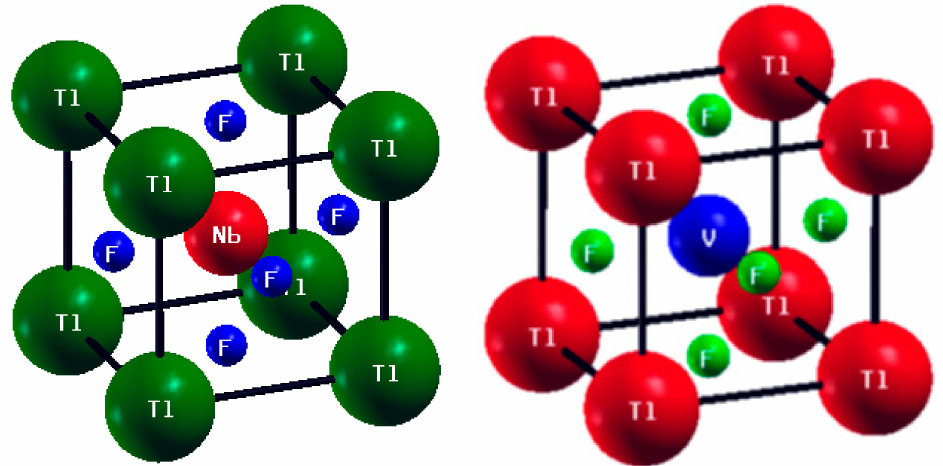
Figure 1. Crystal structures of ABF 3 (A = Tl, B = Nb, V) compounds.